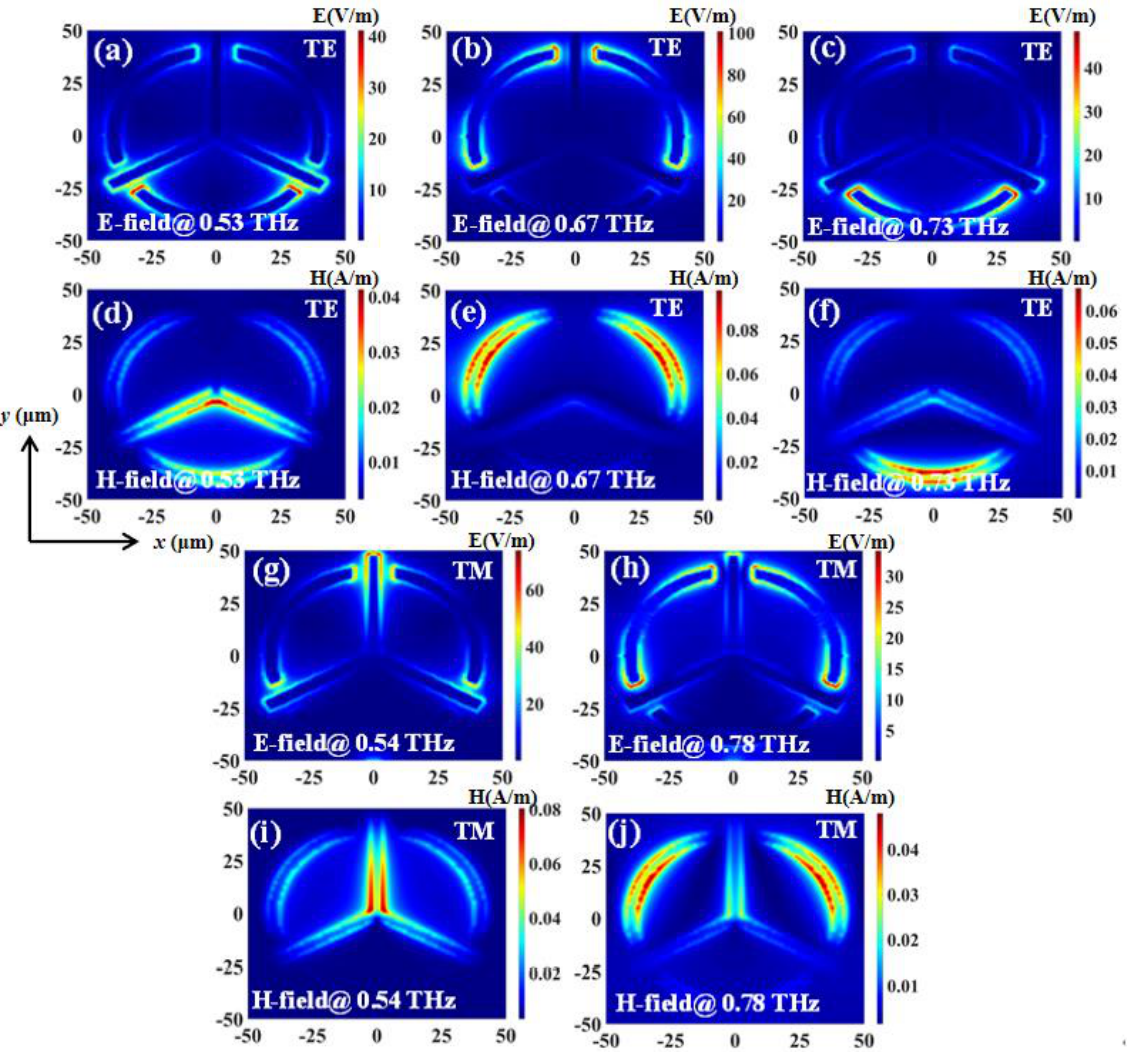
Figure 7. Field distributions of TTM with L = 47.5 µ m and R = 40 µ m in TE and TM modes. ( a – c , g , h ) are E-field distributions. ( d – f , i , j ) are H-field distributions.